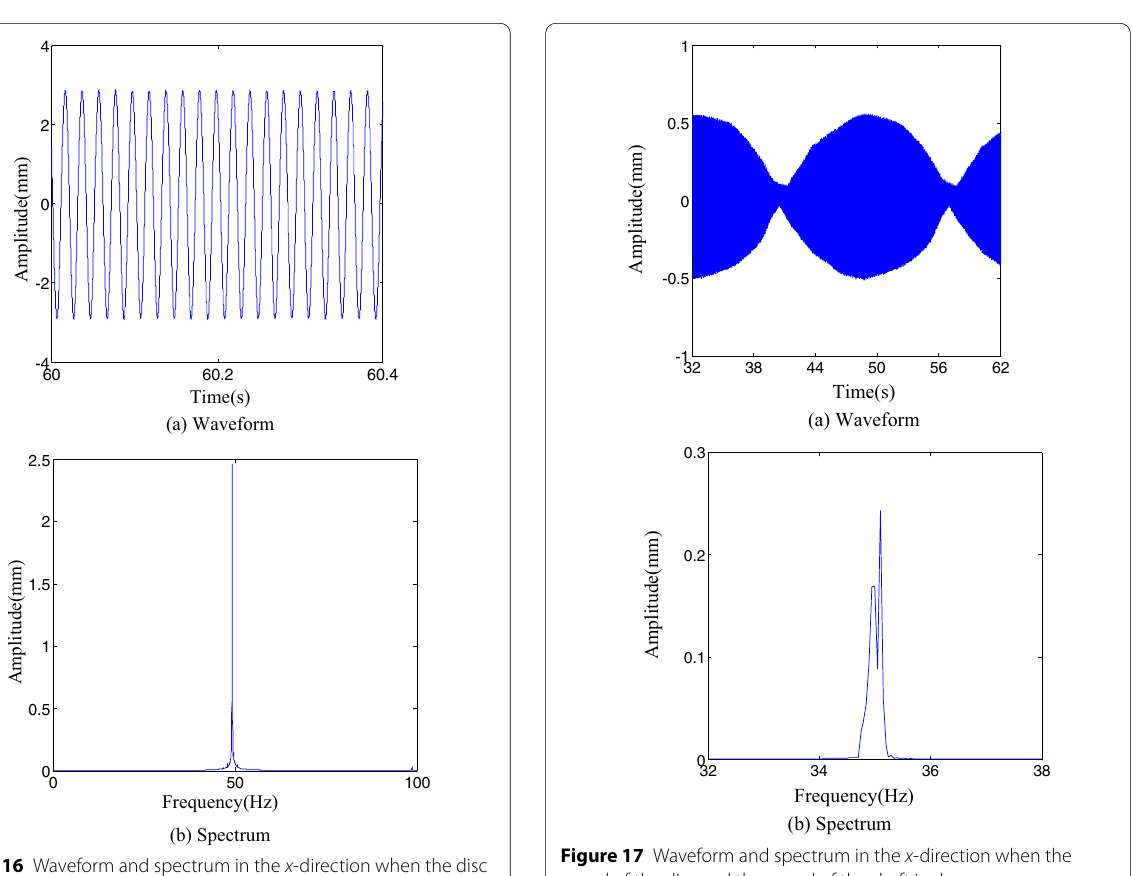
composed of one frequency multiplication component. From Figure 18, when the disc and the shaft have a large difference in rotation speed, compared with Figure 16, except for one frequency multiplication component in the collision frequency, a few weak high frequency mul- tiplication components and a few weak low frequency multiplication components also occur in the collision frequency. From Figure 17, when the speed of the disc and the speed of the shaft is close, the vibration of the disc occurs a beat vibration, the collision frequency is mainly composed of a few low frequency components. The experimental results are consistent with the simu- lation results.